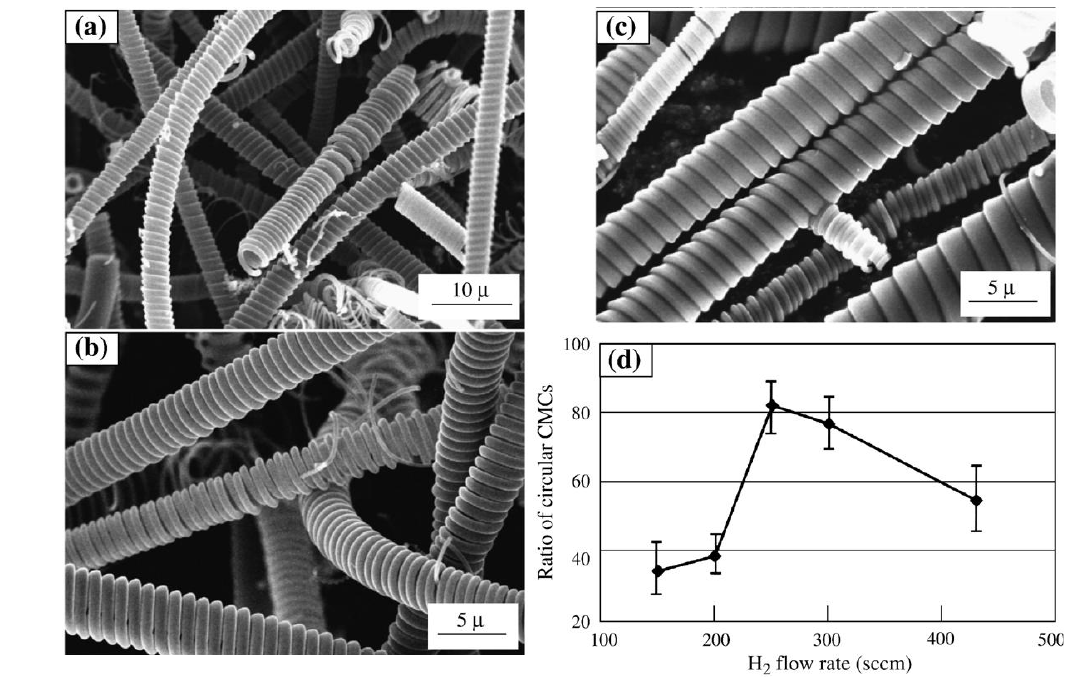
Figure 4. (a–c) SEM images of the CMCs obtained with different H 2 flow rates when N 2 was also introduced. H Other gas flow rates: C temperature: 770 °C; reaction time: 60 min. (d) A summary of the influence of the H rates. Reproduced from [63] with